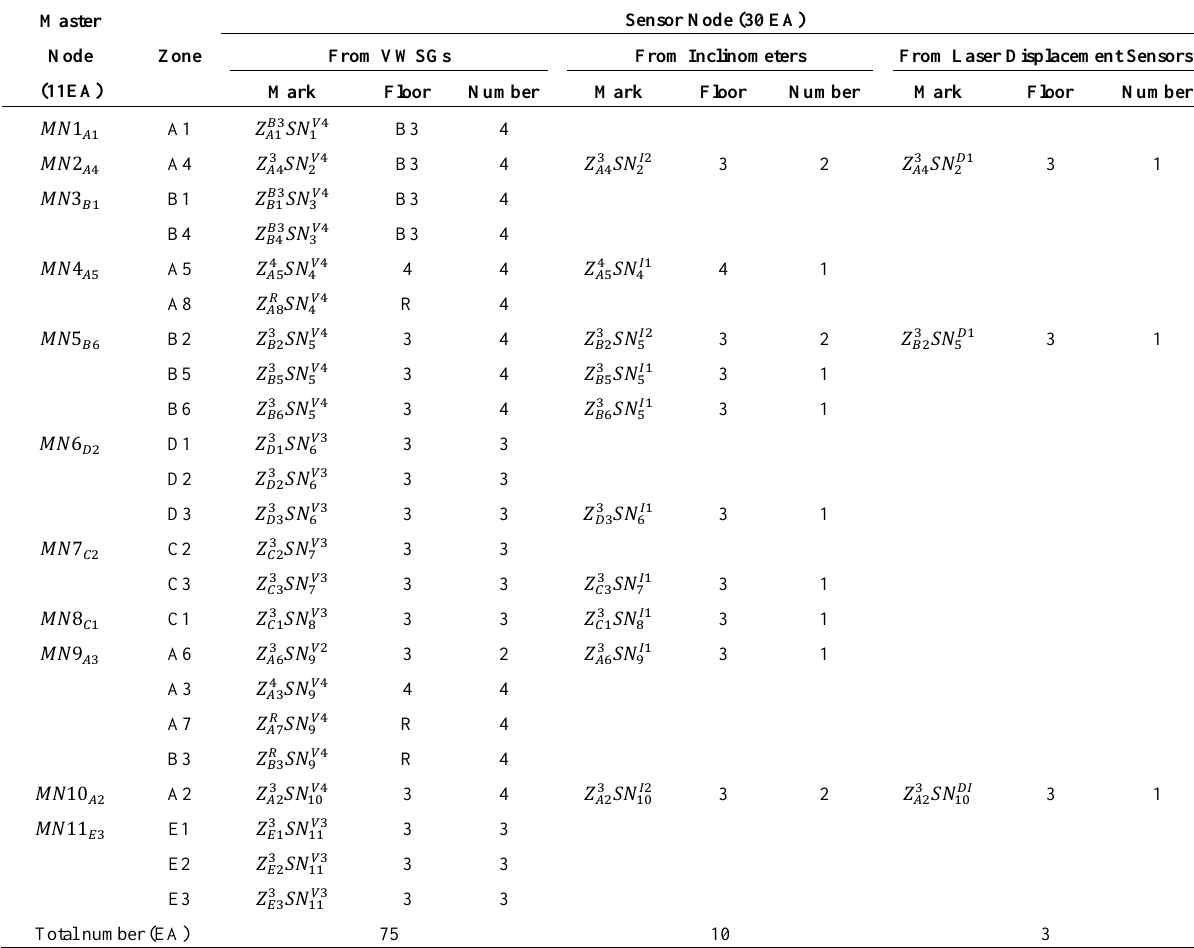
Table 2. Notation for the sensor nodes used at